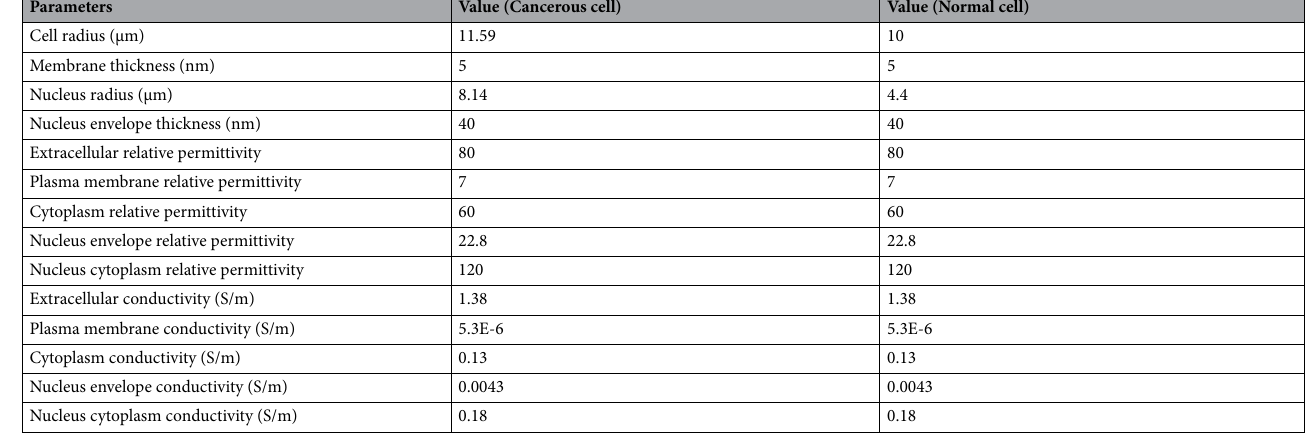
Table 3. The dielectric properties and physical dimensions of cancerous cell and normal cell 20,59–62